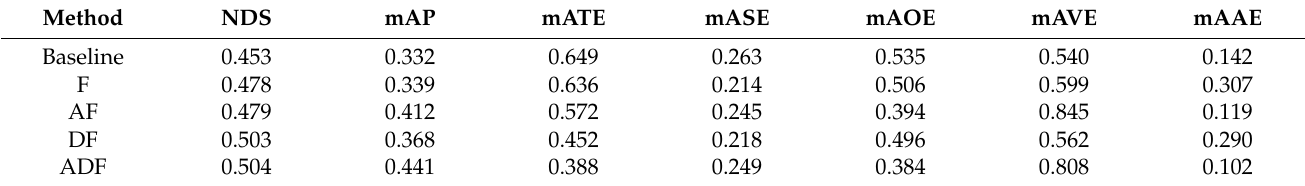
Table 4. Overall performance ablation experiment results on nuScenes test set.